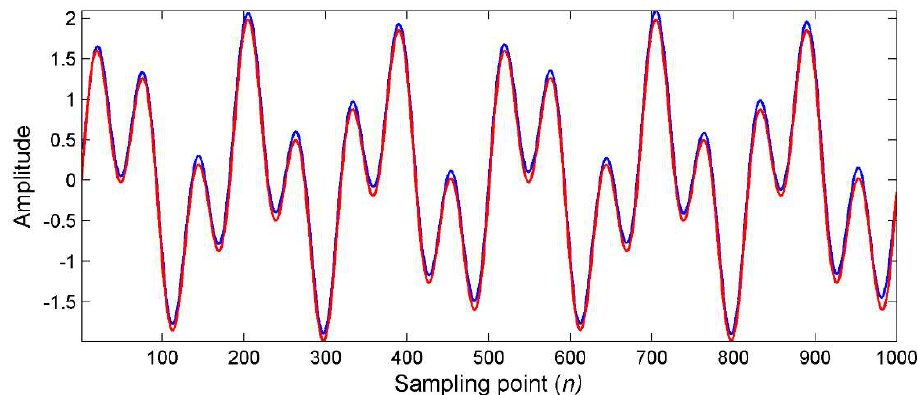
Figure 6. Reconstruction results by VMDC (red) and the original signals without noise (blue).